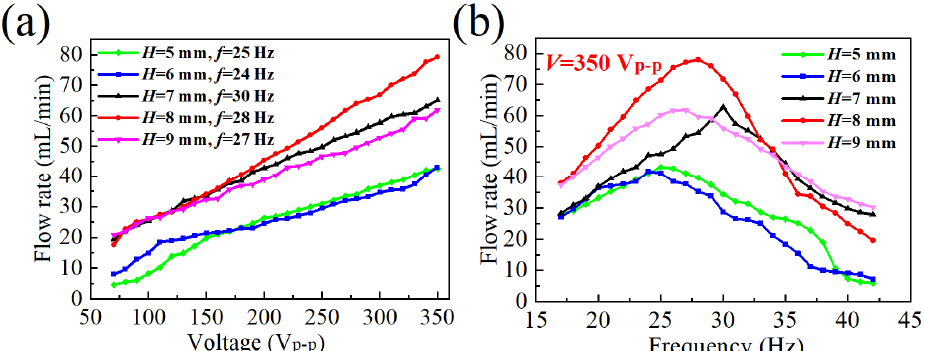
Figure 8. The trend of flow rate with the height of the Tesla valve at different voltages and frequencies: ( a ) the voltage–flow curve; ( b ) the frequency–flow curve.